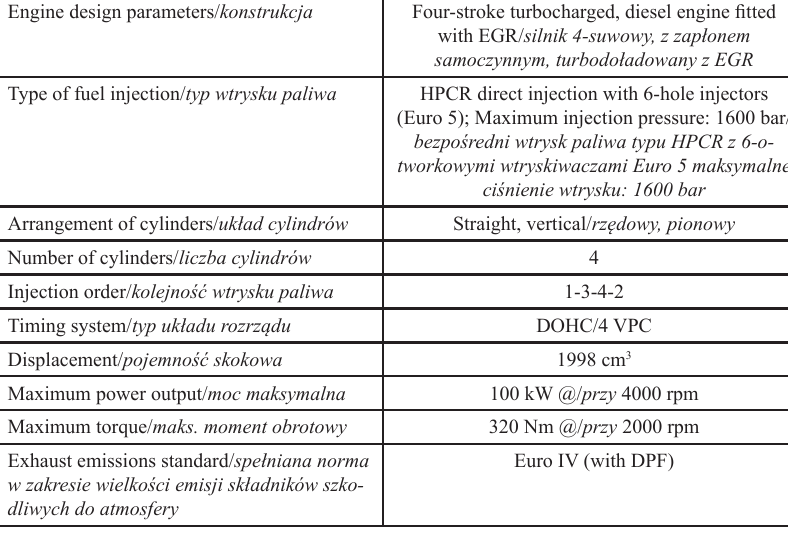
Table 2. Selected parameters of the PSA DW10